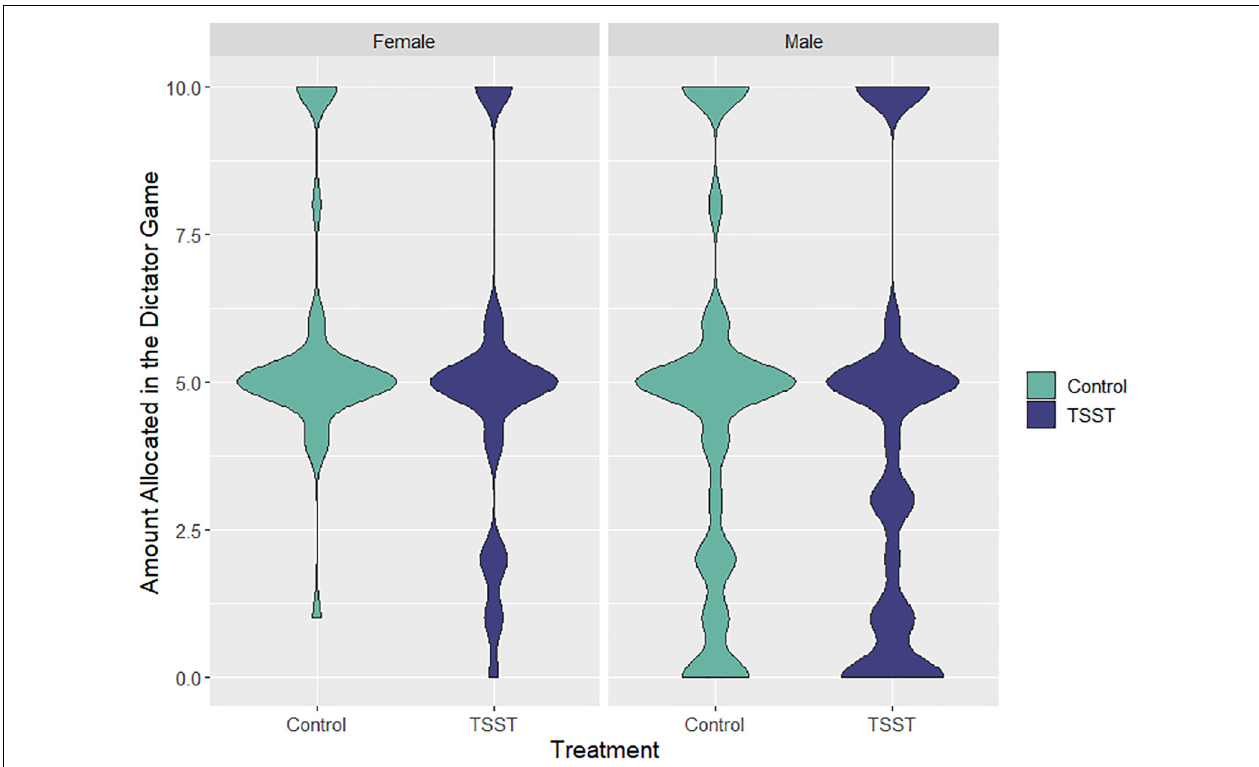
FIGURE 1 | Violin Plots of the amount of money allocated to others by female and male participants in the dictator game. Amount of money allocated was smoothed using a gaussian kernel with bandwidth of 0.3 SD. The graphs on the left depict female participants and the graphs on the right depict results for male participants. Participants in the control group are shown in cyan, while stressed participants are shown in purple. TABLE 1 | Cortisol area under the curve with respect to increase (AUCi), sex, and empathy measure effects on giving in the dictator game. (A) IRI empathy (B) Empathic concern (C) Perspective taking (D) Personal distress (E) Fantasy subscale questionnaire total score subscale subscale subscale